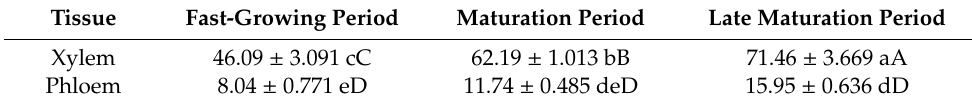
Table 2. Lignin content in the xylem and phloem of ramie stems at three periods (OD · g − 1 DW). Tissue